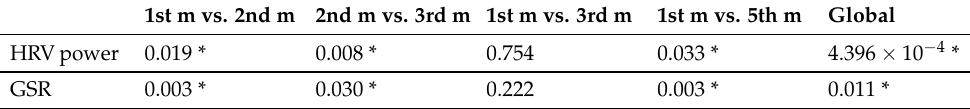
Table 8. Experiment 2 p -values ( p -value below the threshold of 0.05 is marked using